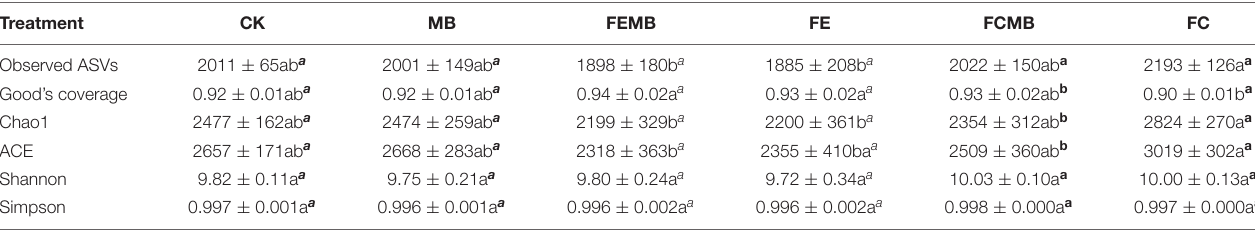
TABLE 3 | Alpha-diversity of bacteria communities in the soil grown with Houttuynia cordata under different fertilization regimens. Treatment